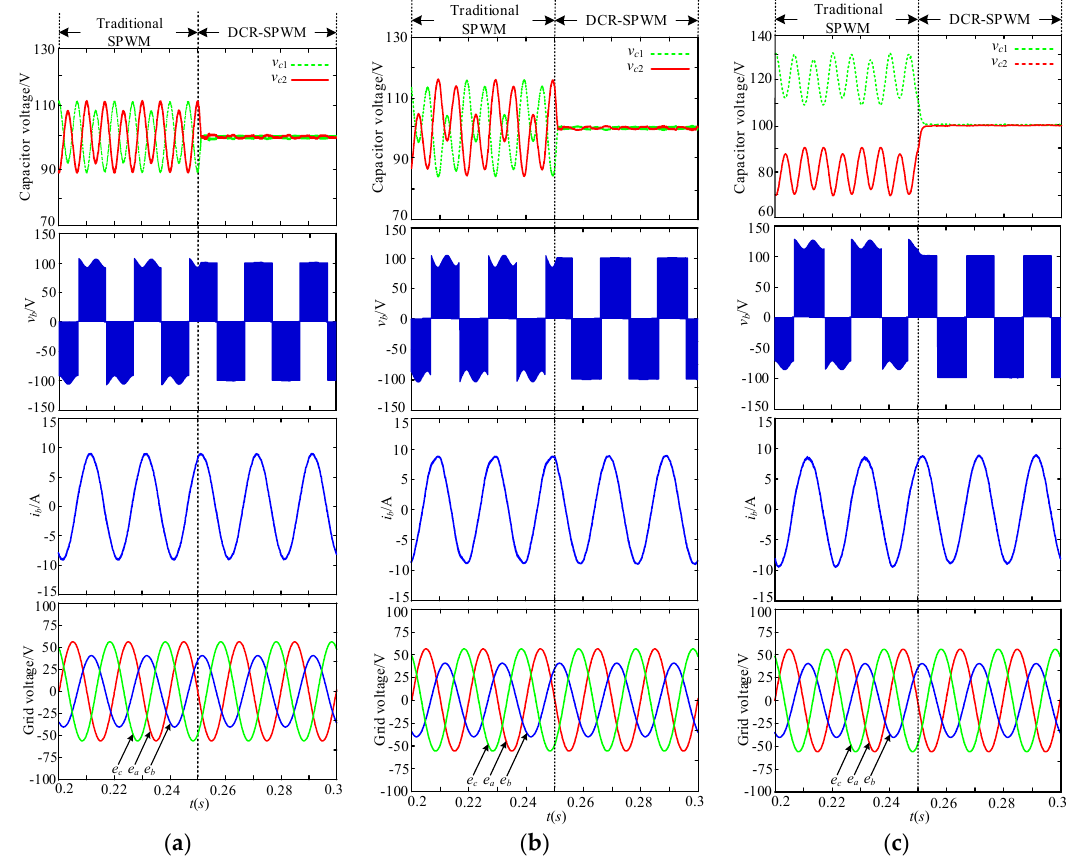
Figure 9. Simulated waveforms of the traditional SPWM and the proposed DCR-SPWM method: ( a ) φ ui = 0, v c 1avg − v c 2avg = 0; ( b ) φ ui = − π /4, v c 1av − v c 2avg = 0; ( c ) φ ui = 0, v c 1avg − v c 2avg = 40 V.